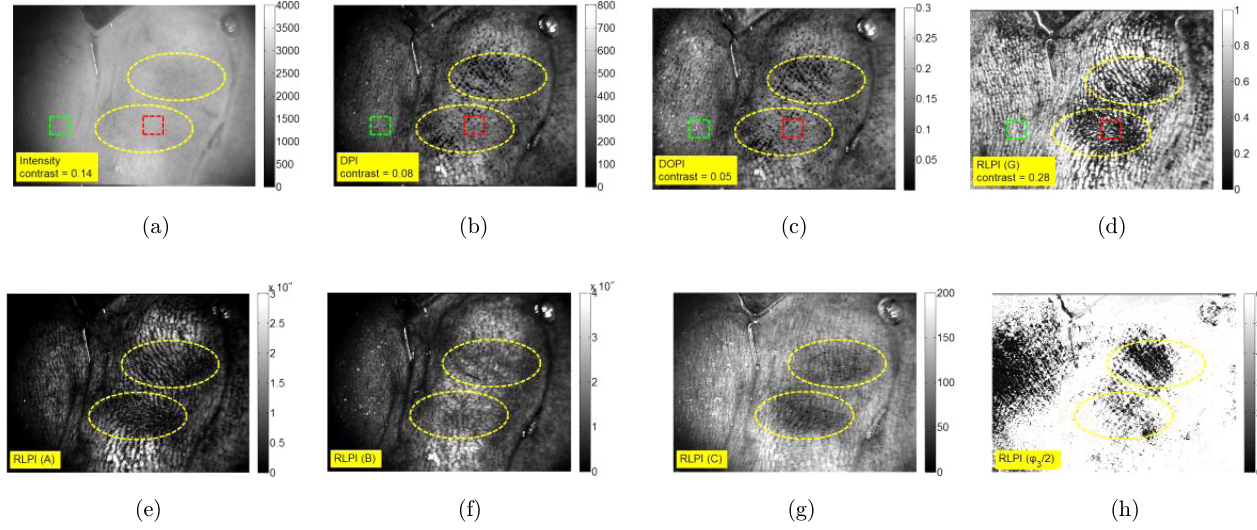
Fig. 3. Experimental results of sample 2: (a) intensity, (b) DP, (c) DOP, (d) G , (e) A , (f) B , (g) ’ 3 /2 and (h) G , for a nude mouse's melanoma with carcinoma B16. The carcinoma areas are marked by yellow circle frames. Contrast between the healthy (marked as green squares) and cancerous skin tissues (marked as red squares) for intensity, DP, DOP and G are: 0.14, 0.08, 0.05 and 0.28.